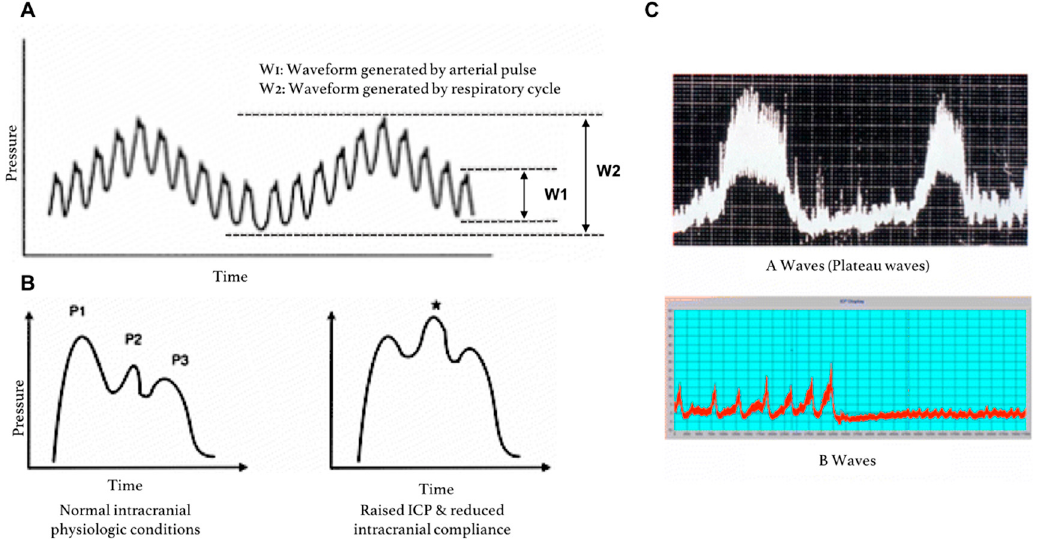
Figure 5. ICP pressure waves. ( A ) ICP fluctuations in response to the respiratory cycle (W2) and the arterial cycle (W1); ( B ) close-up of ICP waveform due to the systemic arterial cycle. Components are P1 (Percussion wave = representative of arterial pulsation), P2 (Tidal wave = a proxy for intracranial compliance) and P3 (Dicrotic wave = pressure transmission of aortic valve closure). A raised P2 wave is an indicator of raised ICP and reduced intracranial compliance (*); ( C ) Lundberg A (plateau) and B waves; adapted from Hall et al. [55].